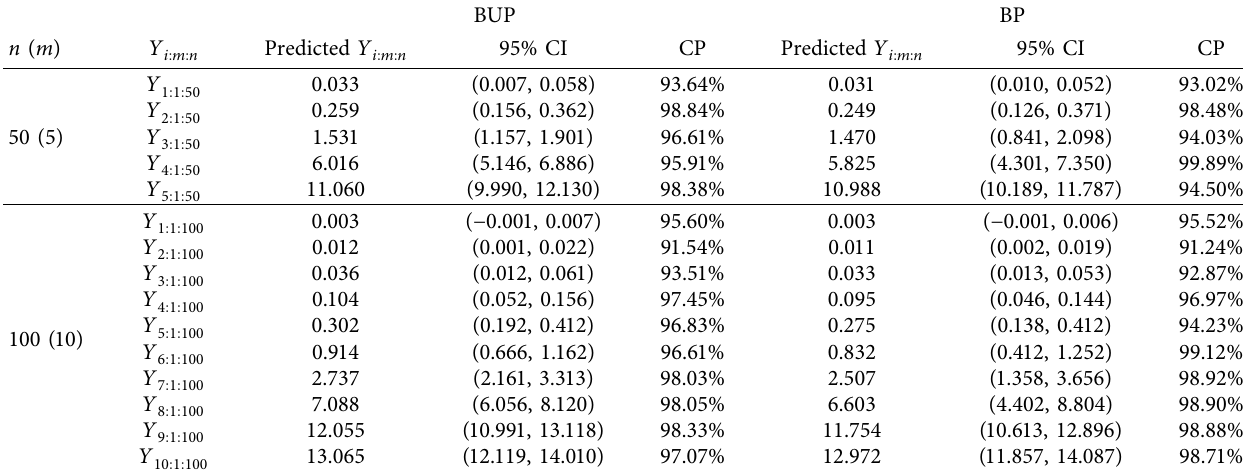
, 1 ≤ i ≤ m , for scheme 1, with α � 0 . 5 , β � 0 . 5. s : r j BUP BP